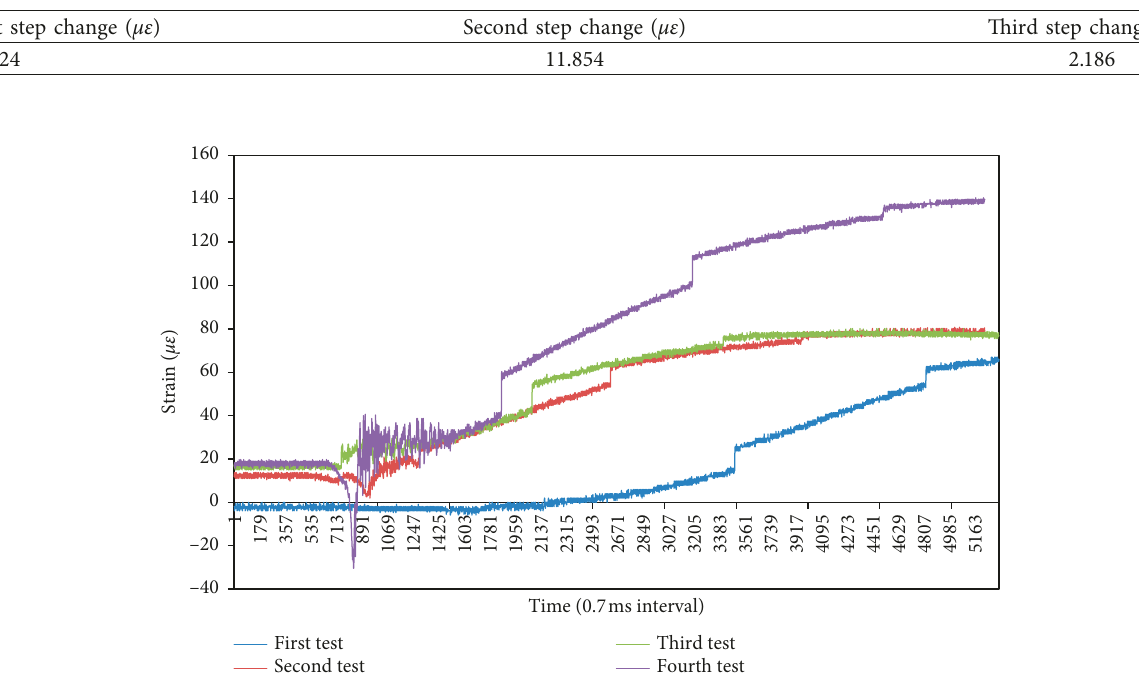
Figure 28: The strain data of the four tests.